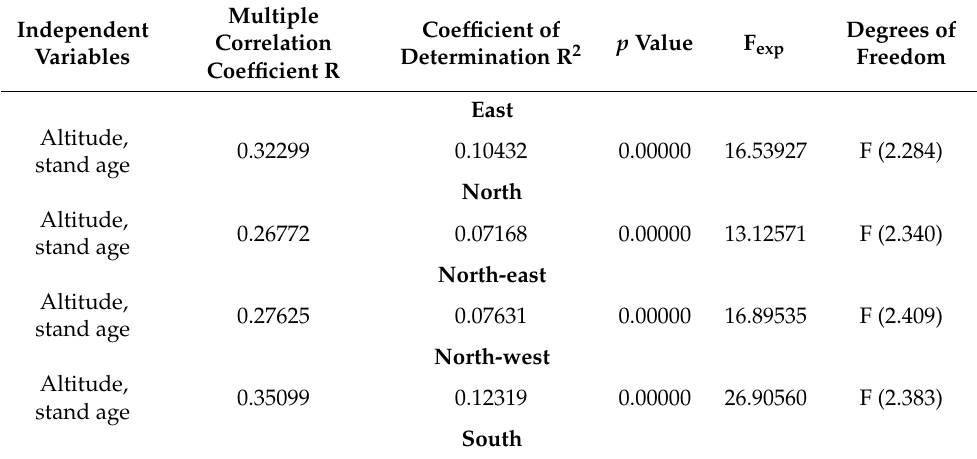
Table 6. Multiple linear regression between altitude, tree age and soil organic matter content for Ao horizon for eutric